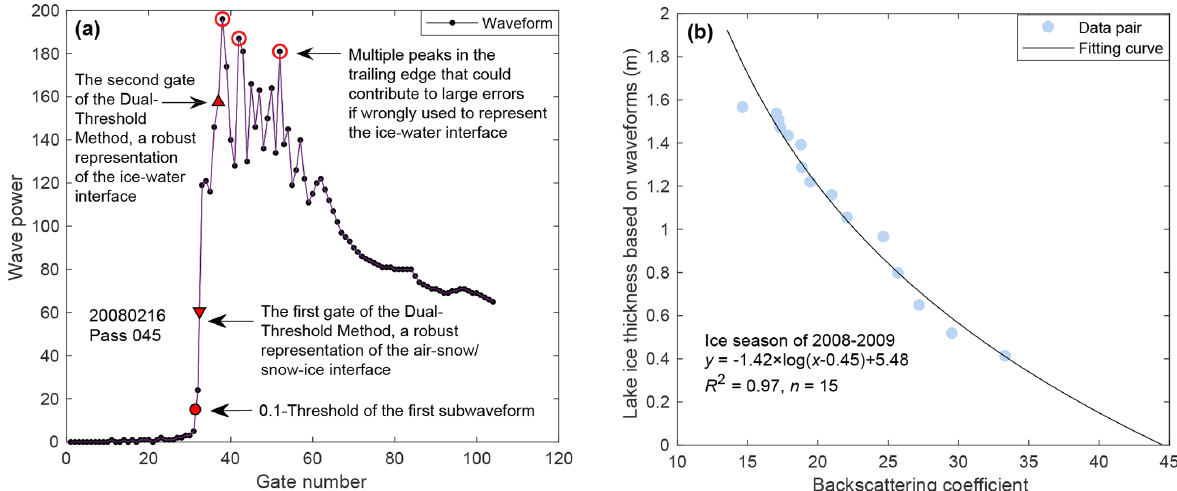
Figure 3. Mechanisms of the LIT estimation based on waveforms and backscattering coefficients. (a) A Jason-2 waveform obtained from ice-covered GSL. Red triangles indicate retracking points derived from the dual-threshold retracking algorithm, which can be used to estimate LIT. The red solid circle denotes the retracking point of the first subwaveform with a 0.1 threshold retracker, which can be used to derive LSH. (b) Scatterplot of the backscattering coefficients and LIT derived from the dual-threshold retracking algorithm through the ice season of 2008–2009 for GSL. Backscattering coefficients can be transformed into LIT with the derived regression model.